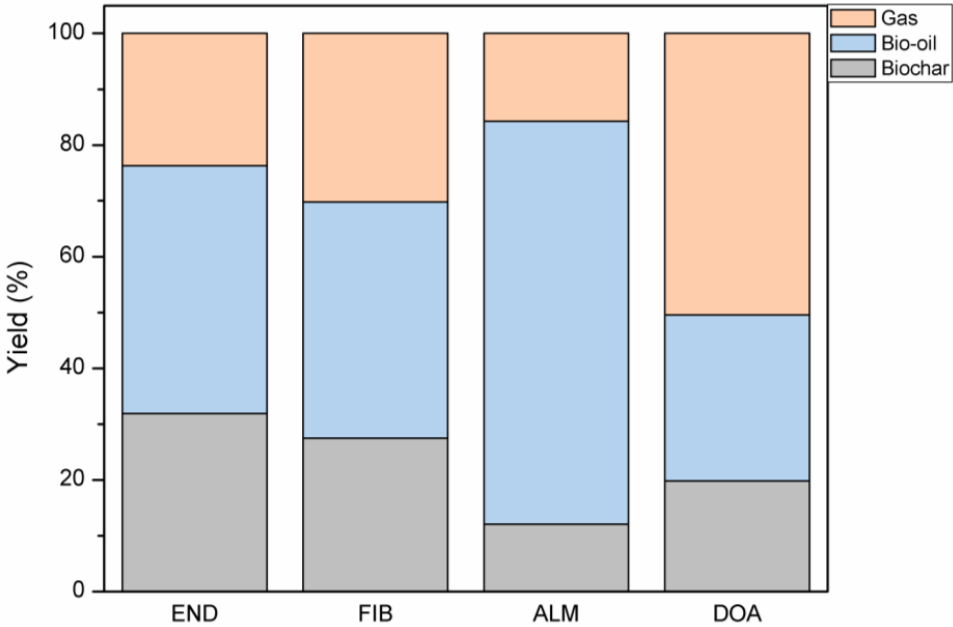
Figure 2. Product yields from pyrolysis of END, FIB, ALM, and DOA at 700 °C. The increase in the cellulose and hemicellulose content leads to higher production of volatile vapor in pyrolysis [20]. This observation explains why DOA (69.6%wt. of cellu- lose and hemicellulose) had the highest gas production, reaching 50.5%wt. In addition, in pyrolysis, cellulose produces more fragments of smaller molecular sizes, increasing liq- uid and gaseous fractions [105]. 2.3. Non-Condensable Gases Generation Regarding gas production, Figure 3 presents the distribution of non-condensable gases affected by temperature. For all precursors, the major gas produced is H 2 which tends to increase in generation with temperature. This tendency was also observed by Perondi et al., (2017) and De Conto et al., (2016) [34,109]. Nevertheless, compared to other samples employed in this work, only END (Figure 3c) still increased H 2 generation 30 min after reaching the isotherm temperature (700 °C). This trend is attributed to lignin de- composition [97]. The H 2 generation should be highlighted since it is a green gas and could be used as a fuel.